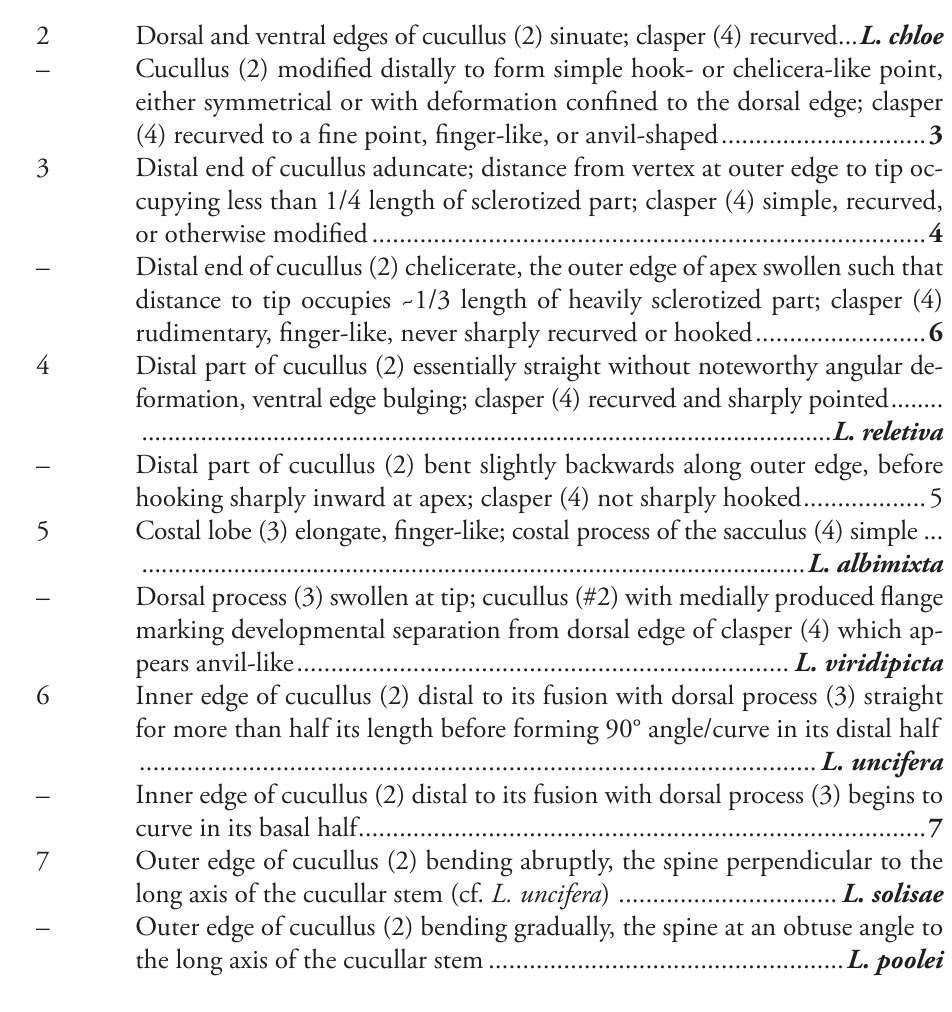
Figs 1–6, 13, 14, 23, 24; Male genitalia: Figs 53–56, 77–80, 111, 112; Female geni- talia Fig. 105 Leucosigma uncifera Druce, 1908: 302. Type locality: Peru: [Puno] Carabaya, La Oroya. Poole (1989) included Leucosigma Hampson, 1908 (preoccupied) as a junior synonym of Leucosigma Druce,